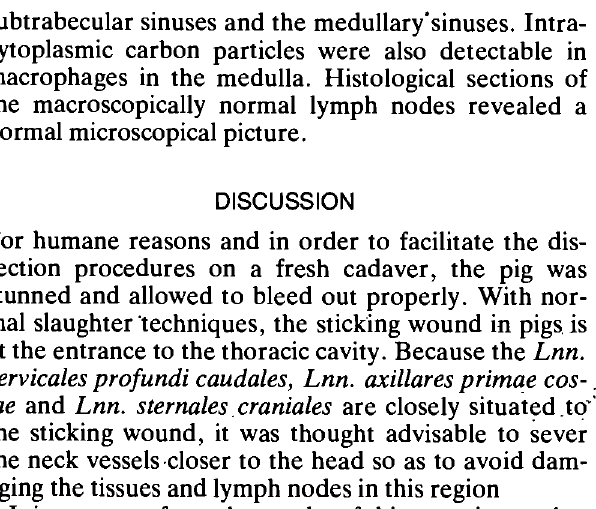
Fig. 2. Lateral surface of the left porcine elbow 1. Musculus triceps brachii caput laterale' 2. M. triceps braqbii caput longum 3. M. (ensor fasciae antebrachii 4. M. brachialis_,: 5. M. extensor caFpi radialis 6, 7, 8. M. extensOr digitalis communis 9, 10. M. extensor digitorum lateralis 11. M. ulnaris lateralis 12,13. M. flexor digitalis